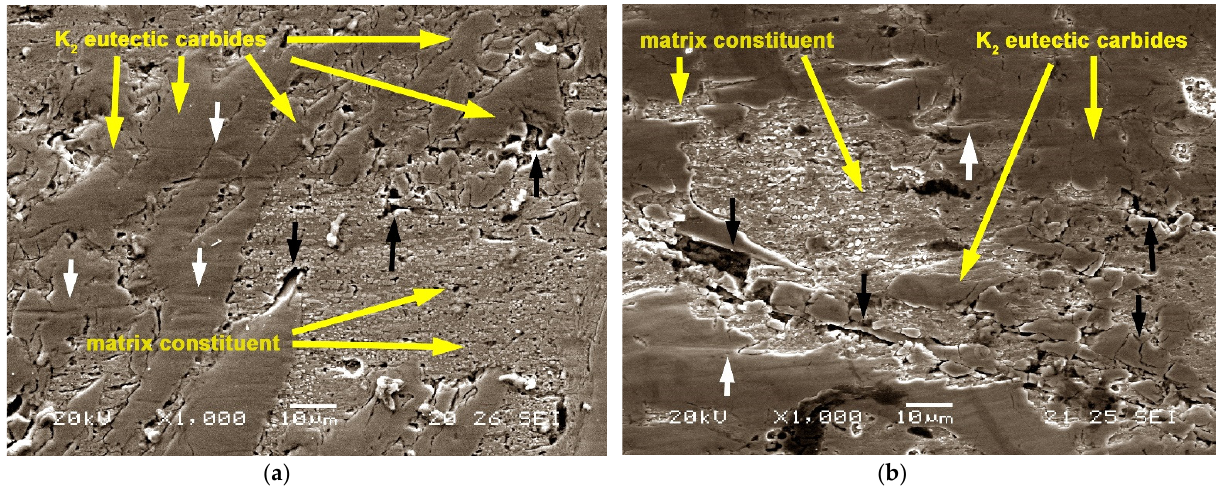
Figure 6. Abrasive wear surface in Scanning Electron Microscope (SEM) ( a ) experiment 1; ( b ) experiment 3. Black arrows show the areas of decohesion of broken eutectic carbides from the matrix constituent. White arrows show shallow scratches on the surface of bulk K 2 eutectic carbides [36,37].